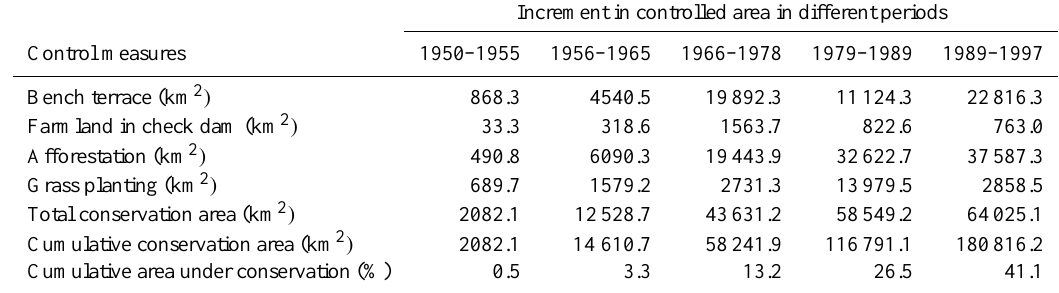
Table 8. Land areas of major conservation practices and percentage area under control measures in different periods in the Loess Plateau in the MRYR basin.